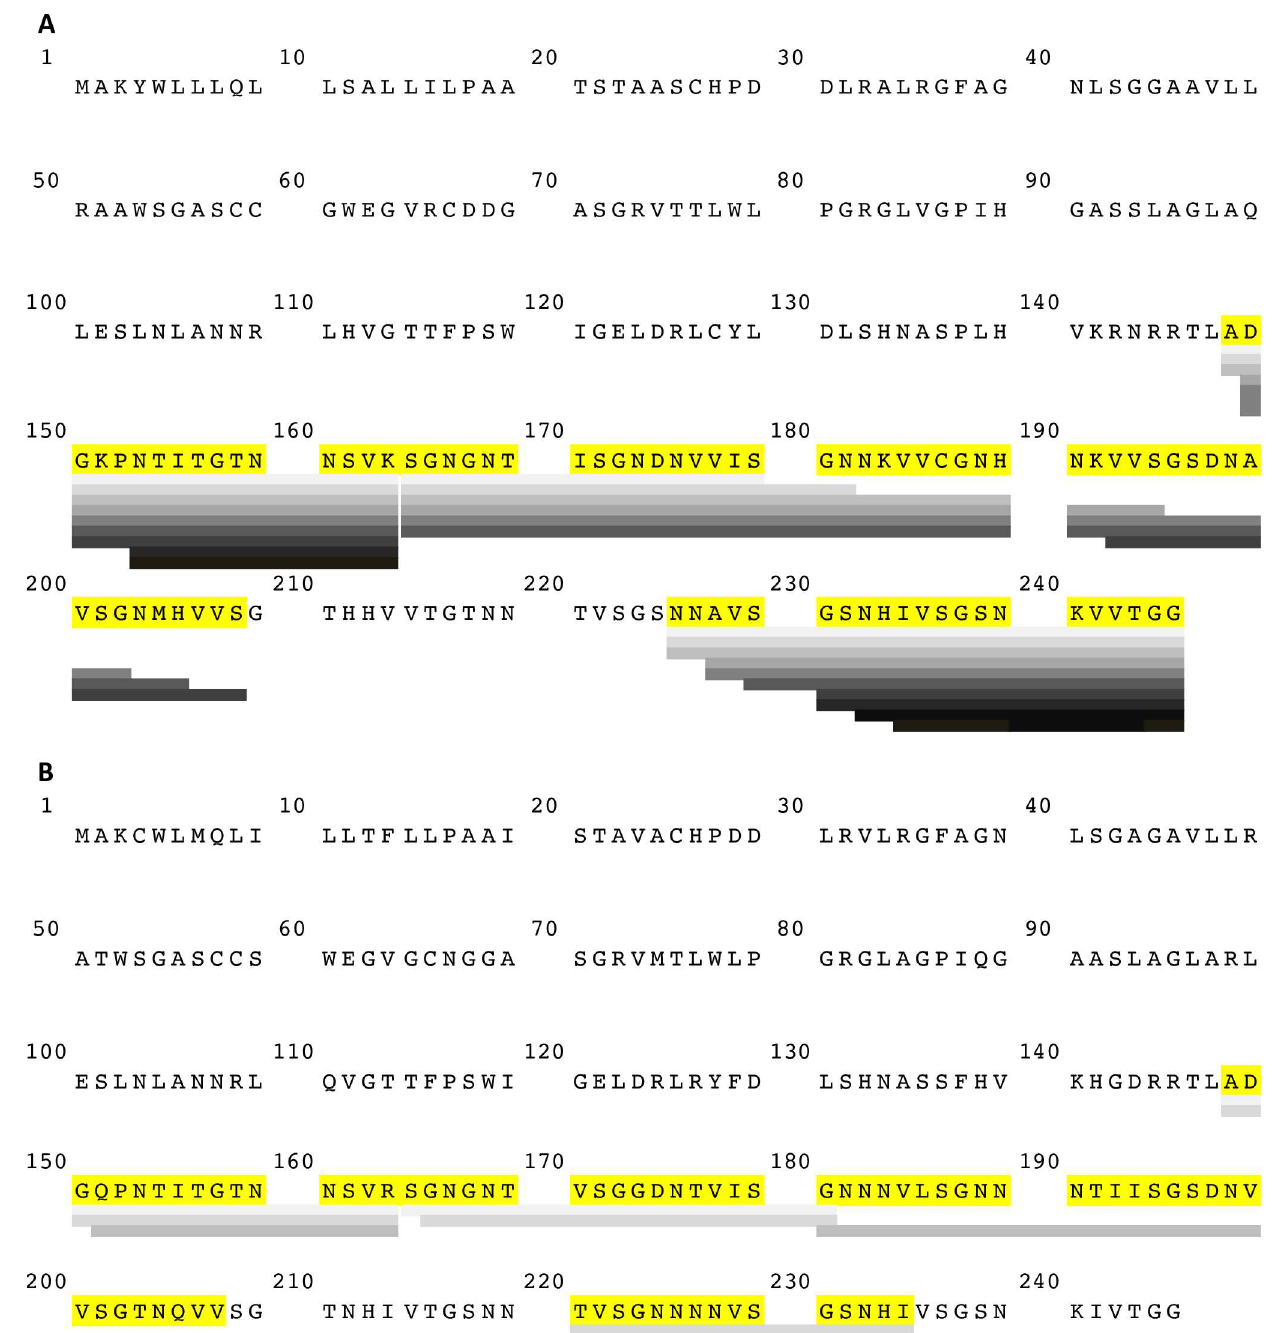
Fig 7. Alignment of Bd IRI peptides recovered by ice-affinity purification. Peptide fragments identifiedby LC-MS/MS were alignedagainst the full-lengthamino acid sequencesof Bd IRI3 (A) and Bd IRI4 (B). Amino acid coverageis indicatedin yellow. Peptide fragments recovered by LC-MS/MS are indicatedby grey